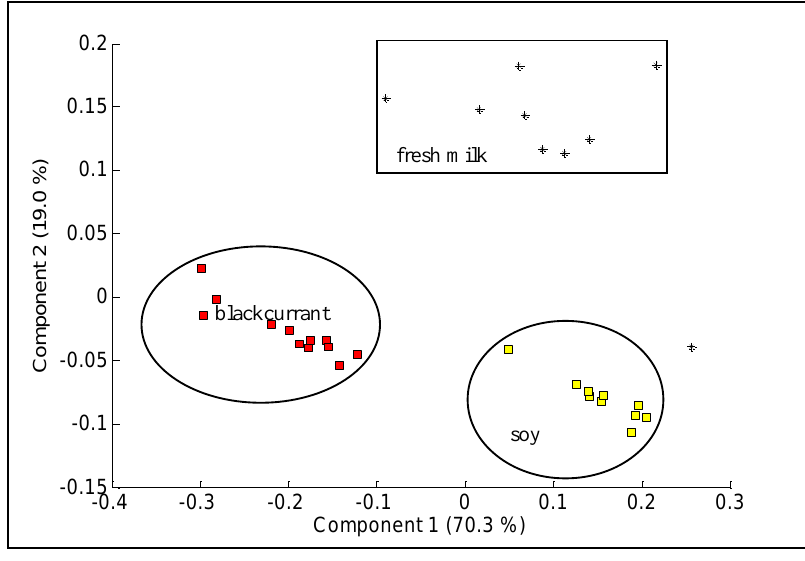
Figure 10. PCA plot of blackcurrant juice, soy milk and fresh milk.